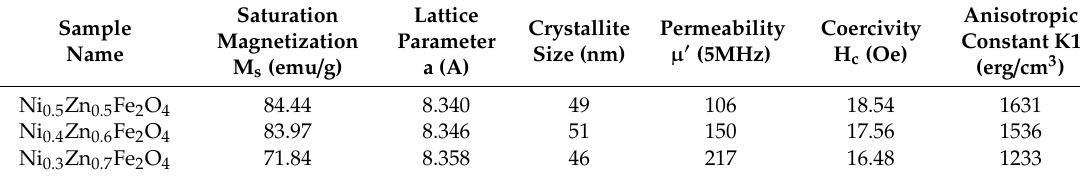
Table 1. Properties of Ni 1 − x Zn x Fe 2 O 4 (x = 0.5, 0.6, 0.7) powder and toroidal